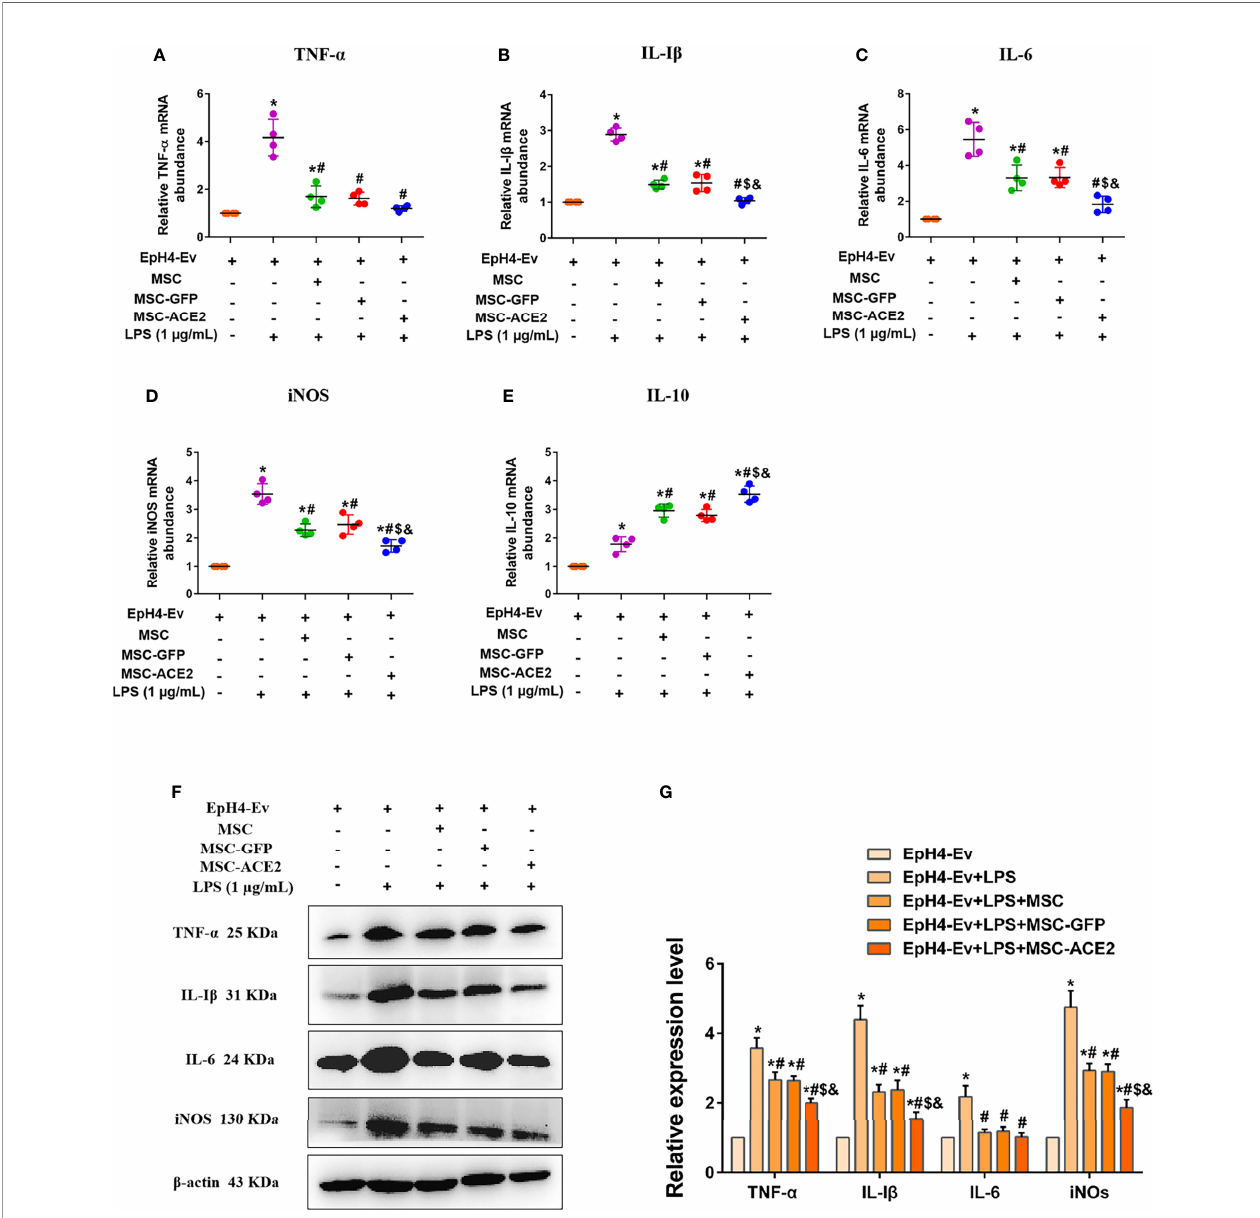
FIGURE 4 | MSC-ACE2 downregulates the production of in fl ammatory mediators. (A – E) Detection of relative transcript levels of TNF- a , IL-1 b , IL-6, iNOS, and IL-10 in EpH4-Ev cells by qRT-PCR. TNF- a , tumor necrosis factor- a ; IL-I b , interleukin-I b ; IL-6, interleukin-6; iNOS, inducible nitric oxide synthase; IL-10, interleukin-10. (F) Detection of relative protein expression levels of TNF- a , IL-1 b , IL-6, iNOS, and IL-10 by Western blot. (G) Statistics of the TNF- a , IL-1 b , IL-6, and iNOS Western blot results. Experiments were repeated three times and data were presented as the mean ± SEM (n = 4). * P < 0.05 vs. EpH4-Ev; # P < 0.05 vs. LPS; $ P < 0.05 vs. MSC; & P < 0.05 vs.